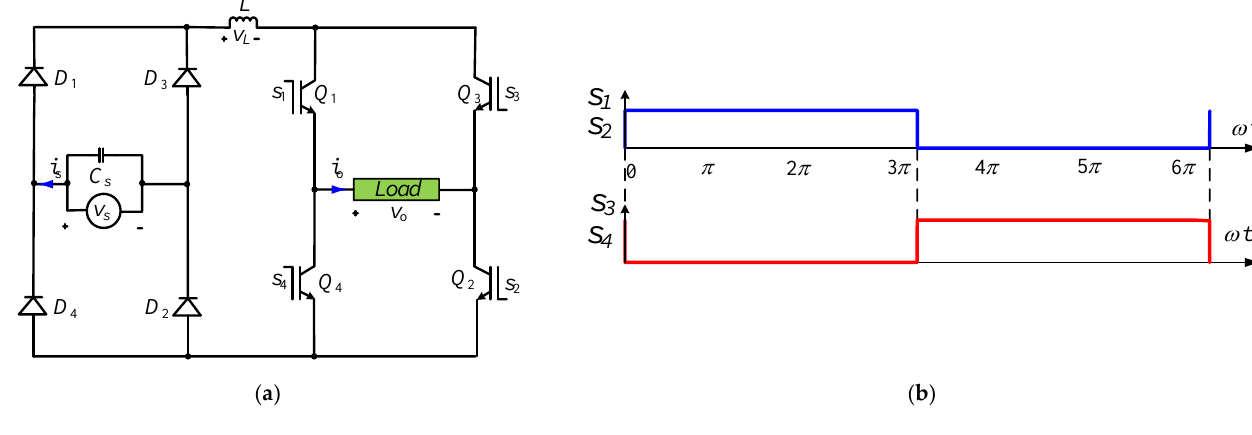
Figure 3. Output frequency control: ( a ) recommended circuit; ( b ) control inputs.